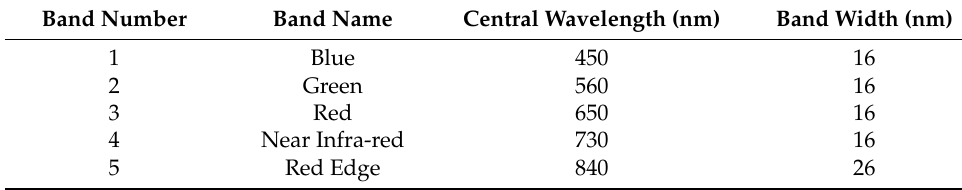
Table 1. Band parameters of the multispectral sensor.